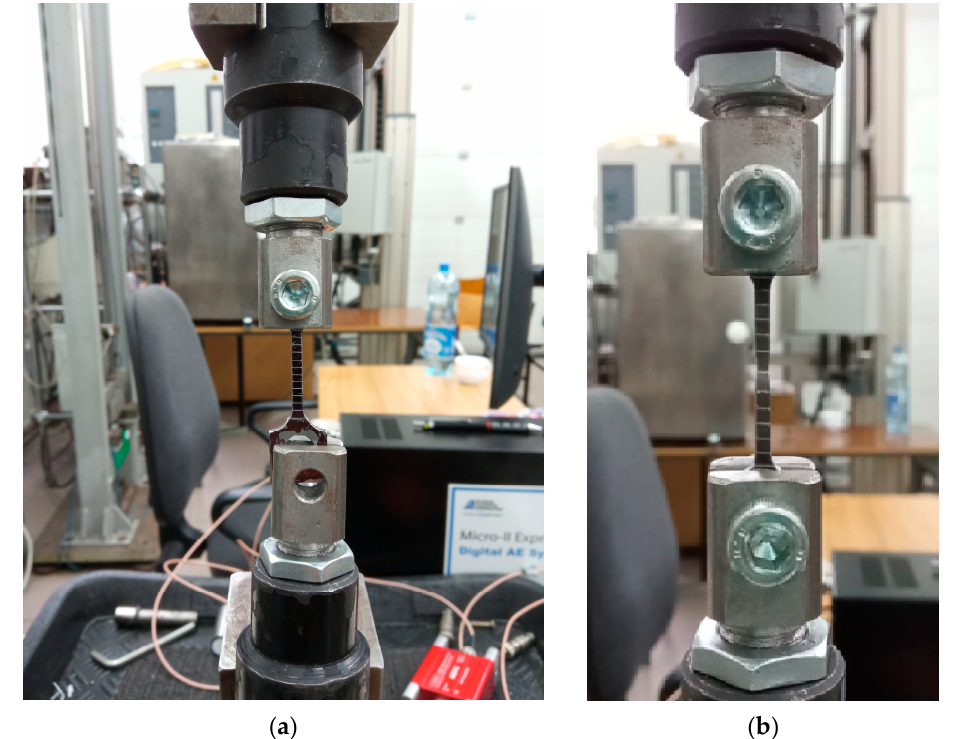
Figure 4. Photographs of the tensile test specimens before test ( a ) and after test ( b ). Fractographic and metallographic testing has been performed using SEM–JEOL JSM-7100F.